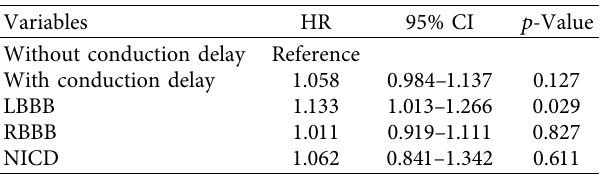
Table 3: Multivariate Cox regression analyses of predictors of